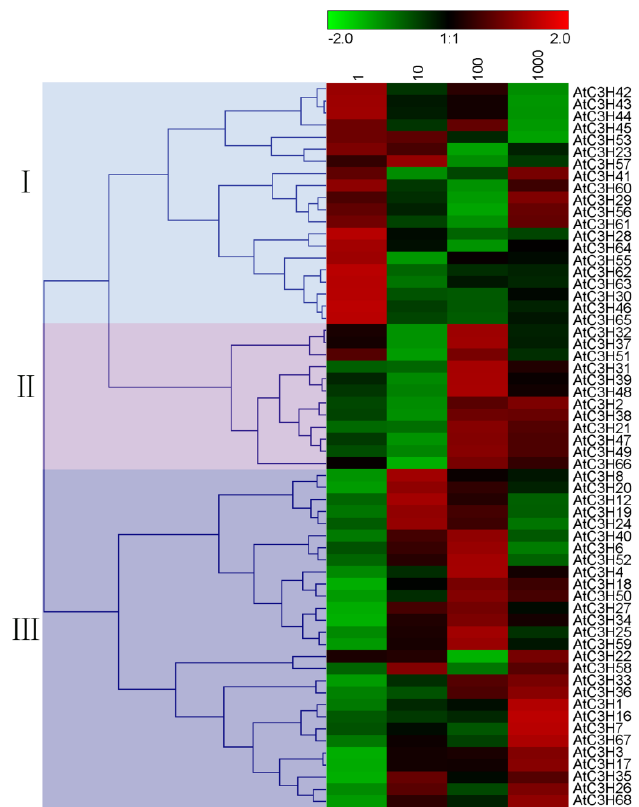
Figure 3. Relative expression levels of Arabidopsis CCCH genes in response to BR. Two − week-old wild − type Arabidopsis seedlings were treated with different concentrations (nM) of 2,4 − eBL for 1 h and sampled for qRT − PCR analysis. Based on the effects of BR on gene expression, three groups (I, II and III) marked with different color backgrounds were classified. Data were normalized and hierarchically clustered based on Pearson correlation. Color scale at the top of heatmap represents log 2 expression value.